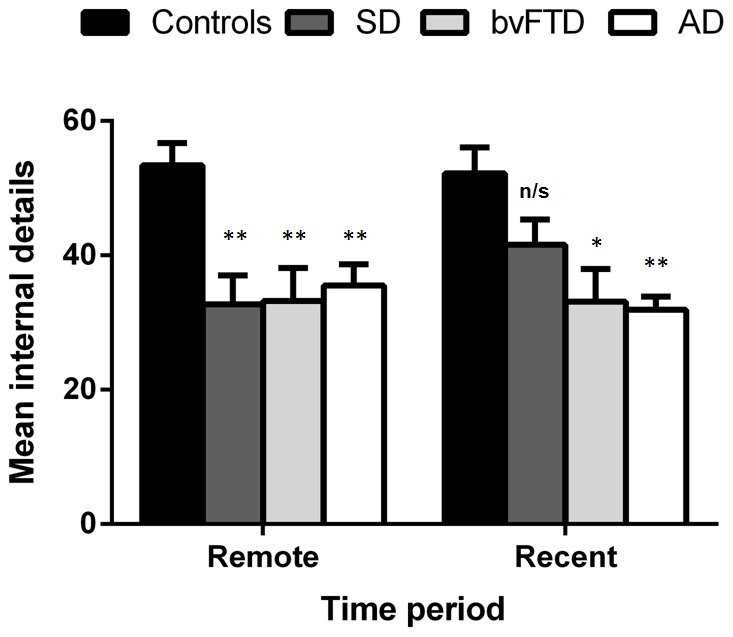
Total internal (episodic) details retrieved across remote and recent periods on the Autobiographical Interview.Error bars represent the standard error of the mean. * p<.05; ** p = .001; n/s = non-significant. Group differences refer to contrasts between patient groups and Controls. No significant differences were evident between the patient groups for remote or recent retrieval.